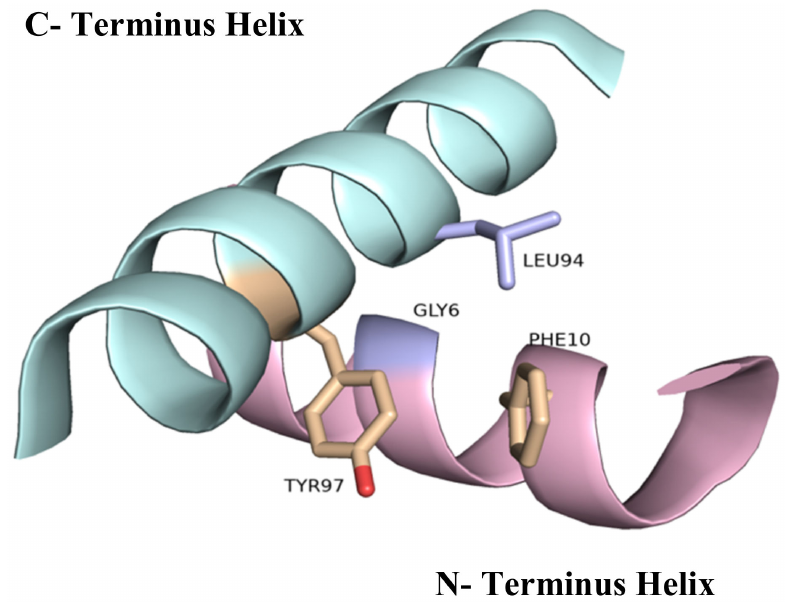
Figure 5. Interface formed between the N and C terminal helices of Cyt c showing key conserved residues in stick model. As shown here, Tyr97 and Phe10, which interact with each other through an aromatic–aromatic interaction, while Leu94 is in close proximity to Gly6 (PDB: 1HRC). The binding of the heme group of Cyt c is crucial to its ability to transport